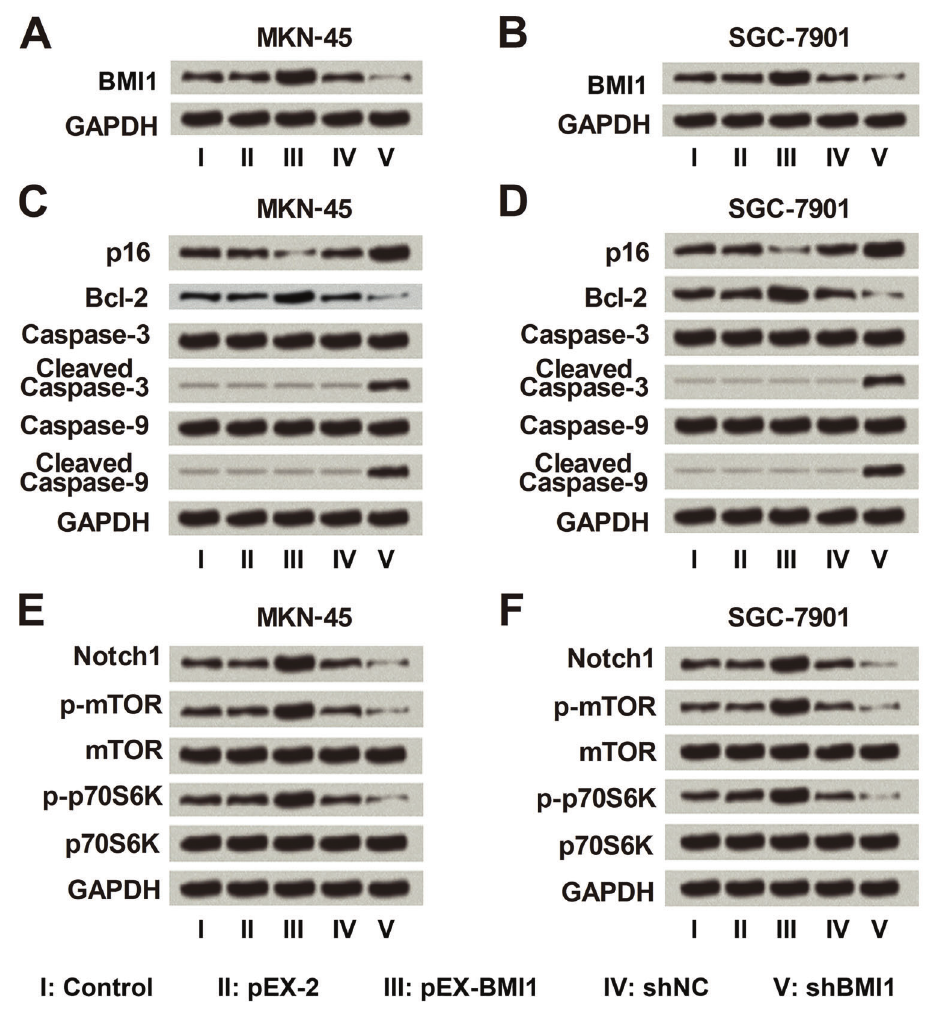
Figure 6. BMI1 inhibited the apoptotic pathway and activated the Notch and mTOR pathways. Protein expression was determined by western blotting. A and B , BMI1 was abnormally expressed after cell transfection. C and D , Bcl-2 expression was down-regulated while expressions of p16, cleaved caspase-9, and cleaved caspase-3 were up-regulated by BMI1 silence. E and F , Phosphorylated levels of key kinases in the Notch and mTOR pathways were increased by BMI1 overexpression. BMI1: B-lymphoma Mo-MLV insertion region 1; pEX-BMI1: recombined overexpression vector of BMI1; shBMI1: pENTR TM /U6 vector carrying small hairpin RNA targeting BMI1; shNC: pENTR TM /U6 vector carrying a non-targeting sequence; p16: multiple tumor suppressor 1; Bcl-2: B-cell lymphoma 2; mTOR: mam- malian target of rapamycin; p70S6K: p70 ribosomal protein S6 kinase; p-: